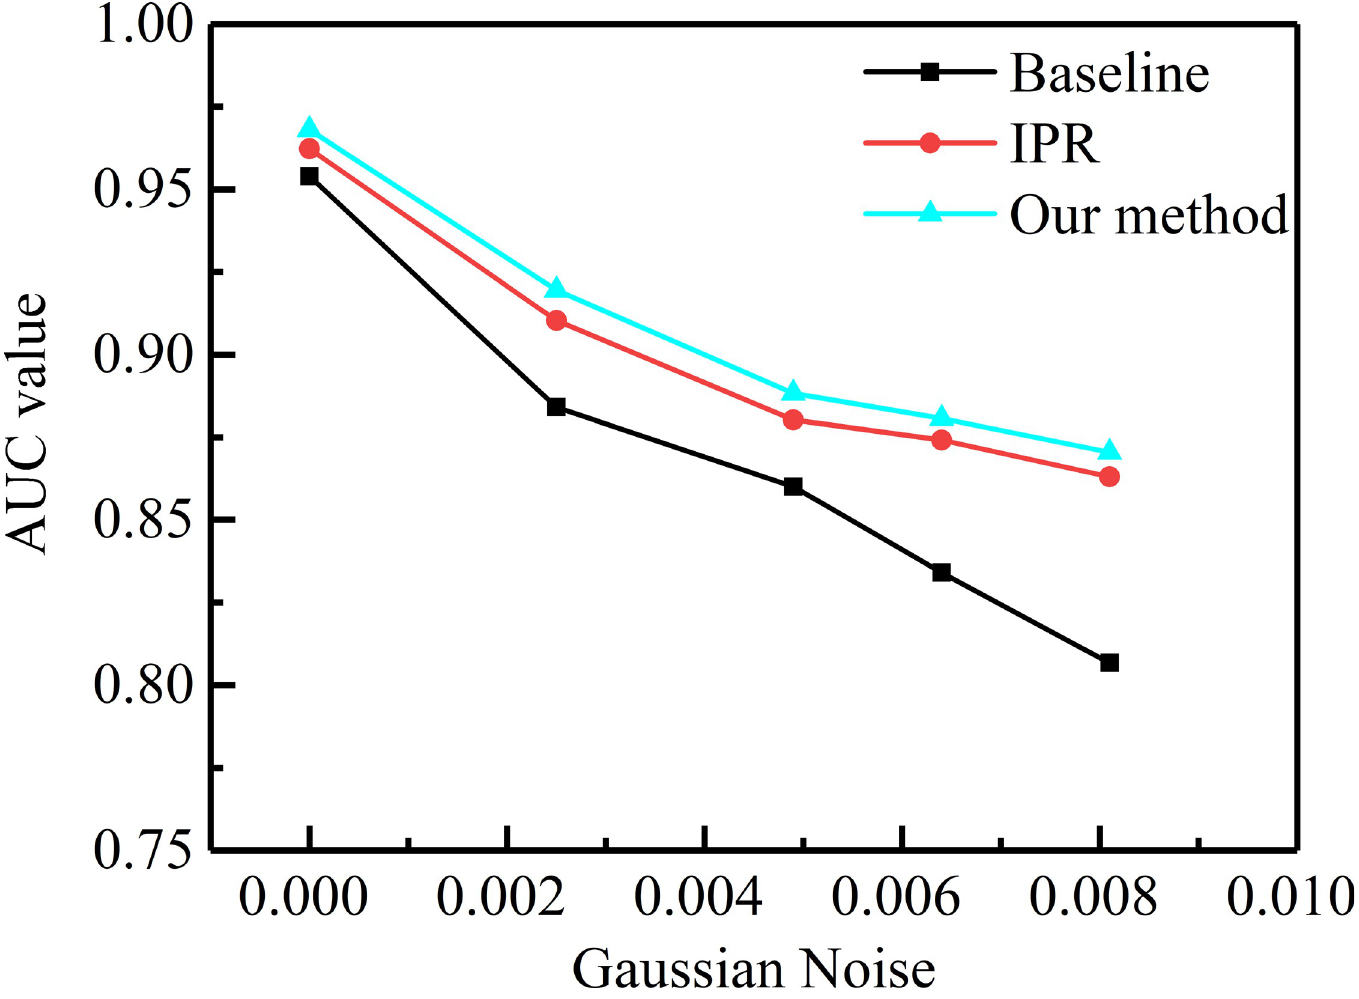
Fig 11. AUC value of different methods in different Gaussian